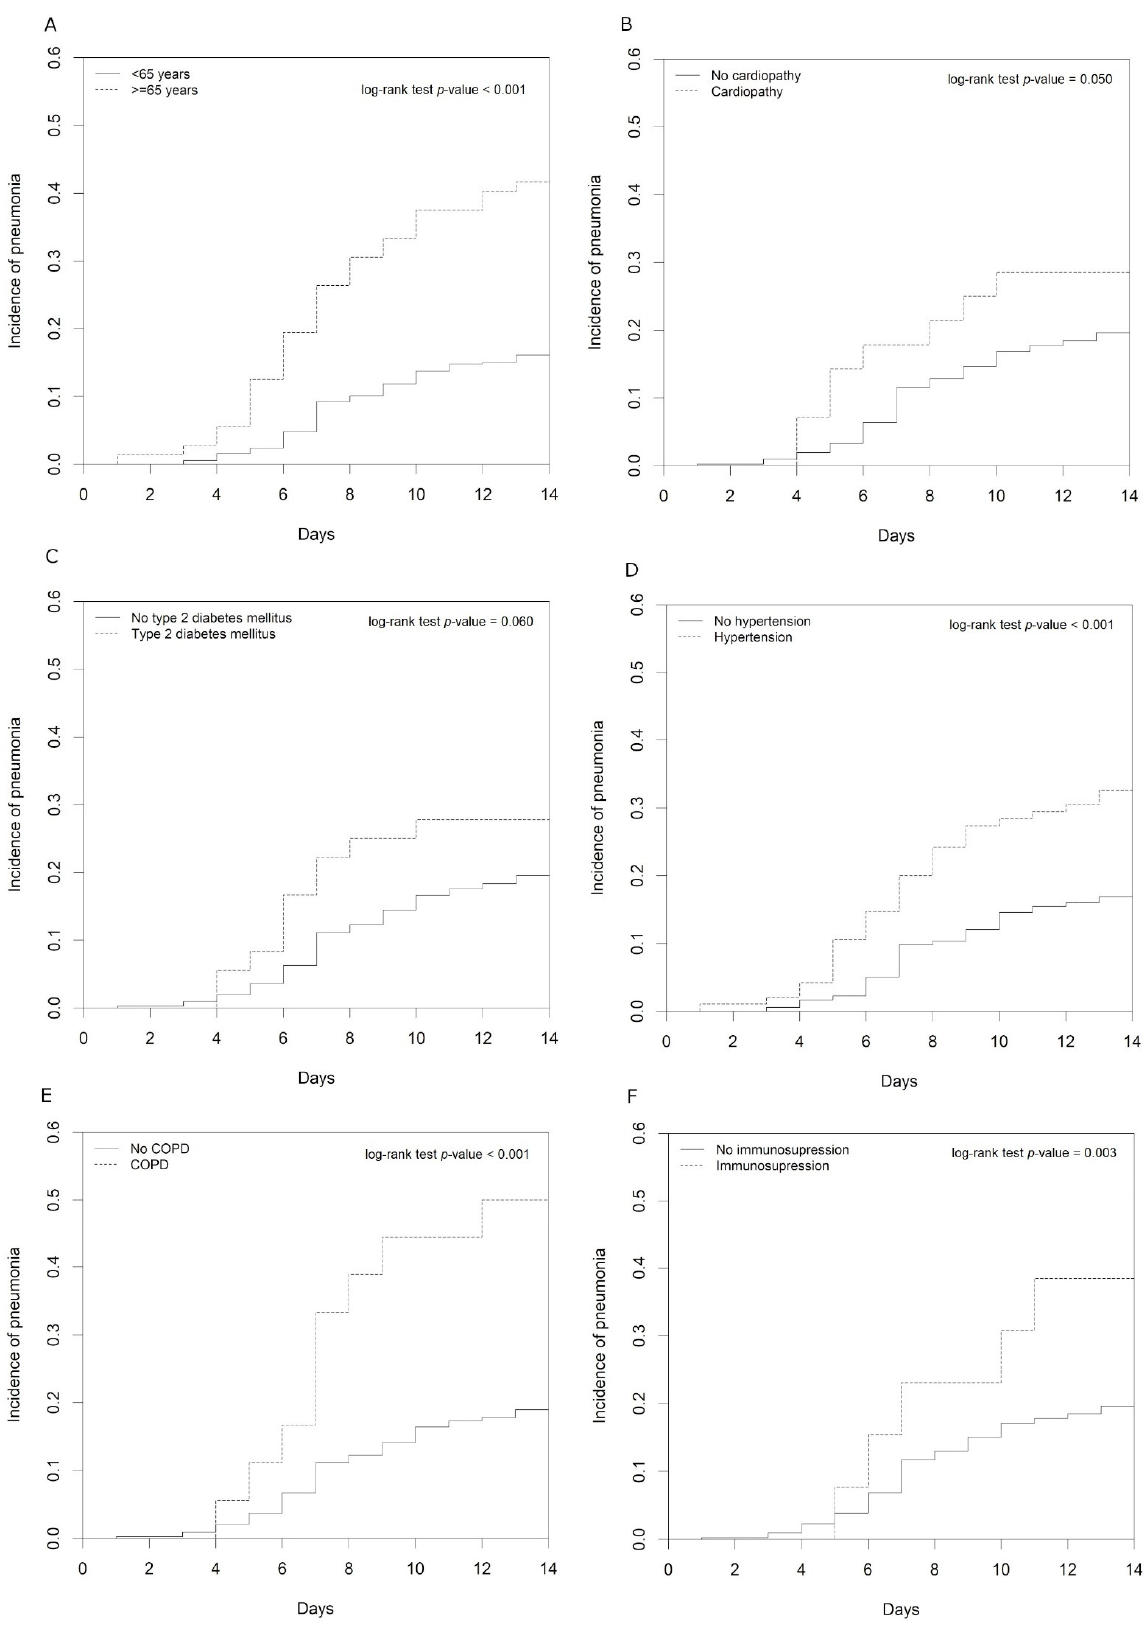
Figure 4. Cumulative incidence function for SARS-CoV-2 pneumonia by age (<65 and ≥ 65 years) ( A ), cardiopathy ( B ), type 2 diabetes mellitus ( C ), hypertension ( D ), chronic obstructive pulmonary disease (COPD) ( E ) and immunosuppression ( F